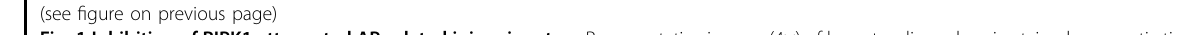
Fig. 1 Inhibition of RIPK1 attenuated AP-related injury in rats. a Representative images (4×) of hematoxylin and eosin-stained pancreatic tissues harvested from rats subjected to sham operation, AP, AP + Nec-1 or AP + DMSO for 24 h after AP induction. b Histopathological scoring was performed to evaluate pancreatic injury in the rats as described above. c The levels of MDA, LDH, MPO, and LPO in pancreatic tissues harvested from the rats described above were assessed spectrophotometrically. d ATP levels were quanti fi ed in pancreatic tissues harvested from the rats. e The levels of CRP, TNF- α , IL-18, IL-1 β , and IL-6 in peripheral blood samples harvested from the rats described above were spectrophotometrically measured. f EMSA analysis and g quantitation of NF- κ B DNA-binding activity in pancreatic tissues harvested from the rats described in Fig. 1a. The data are presented as the means ± S.Ds. ( n = 3). * P < 0.05 versus sham, ^ P < 0.05 versus AP